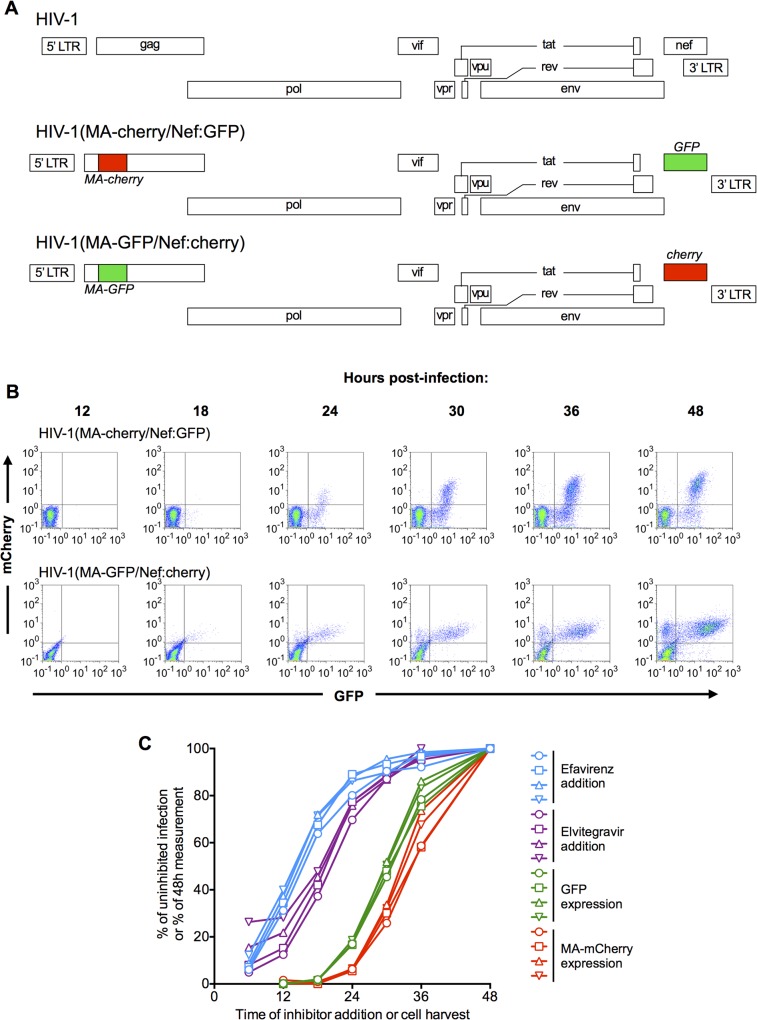
Dynamics of HIV-1 replication measured using dual reporter viruses.(A) Schematic representation of the HIV-1 genome, and derivatives HIV-1(MA-cherry/Nef:GFP) and HIV-1(MA-GFP/Nef:cherry) encoding dual-reporters to study early and late gene expression. (B) Flow cytometric analysis of MT4 cells following synchronized infection with each of the dual-reporter viral constructs displayed in (A). FACS plots with gates for GFP-positive and mCherry-positive cells are displayed. (C) MT4 cells were infected with HIV-1(MA-cherry/Nef:GFP) at four different MOIs: 0.1 (circles), 0.2 (squares), 0.4 (triangles), and 0.8 (inverted triangles). Inhibitors of reverse transcription (Efavirenz, blue lines and symbols) or integration (Elvitegravir, purple lines and symbols) were added at the indicated times. The cells were fixed at 48h. post-infection and analyzed by flow cytometry, and the number of infected cells (as indicated by expression of a Nef:GFP reporter) is plotted as a percentage of that observed if inhibitor was never added. Alternatively, cells were harvested at the indicated times and the number of GFP-positive and mCherry positive cells plotted as a percentage of the 48h maximum value.